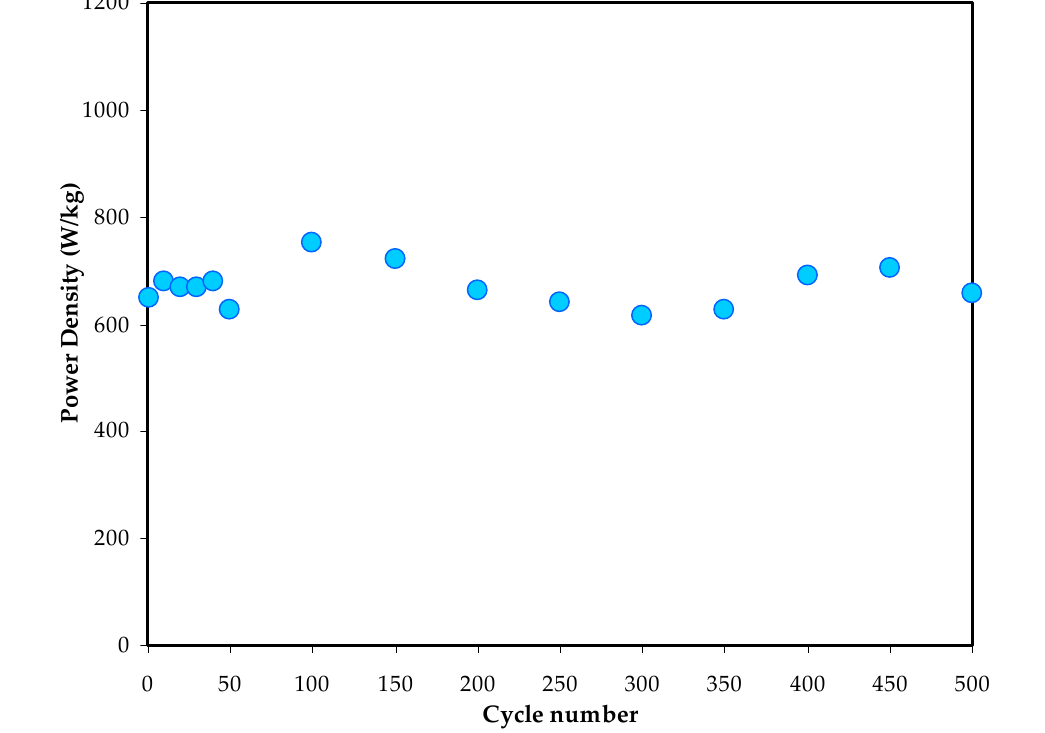
Figure 20. The p trend of the EDLC assembly over 500 cycles.